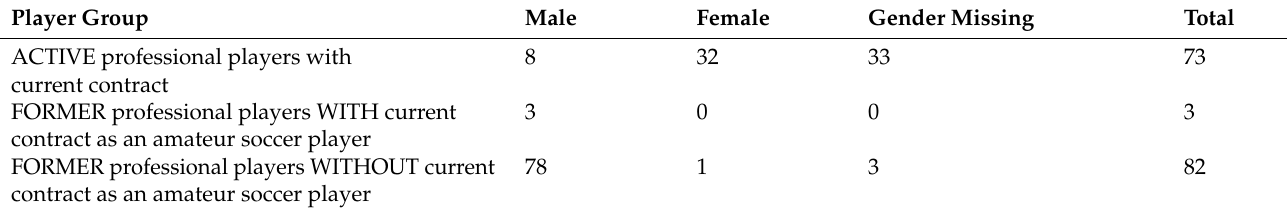
Table 2. Composition of the sample (absolute